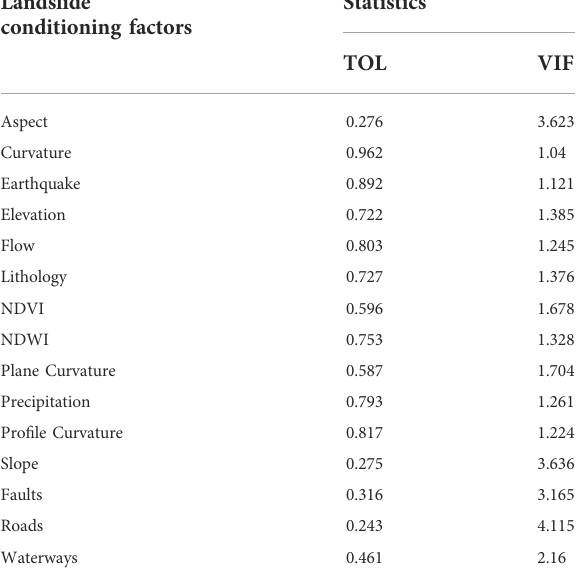
TABLE 1 Outcomes of Multicollinearity